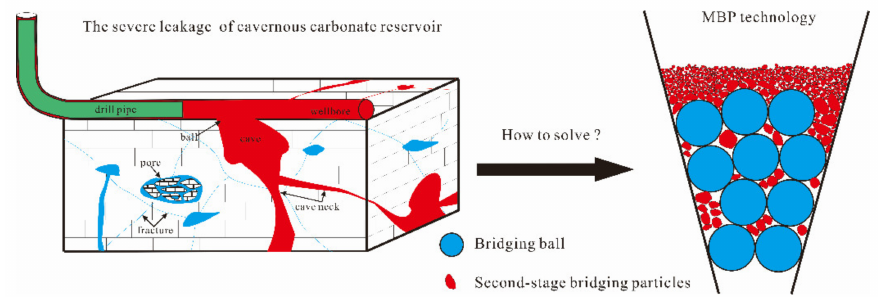
Figure 2. The design idea of MBP